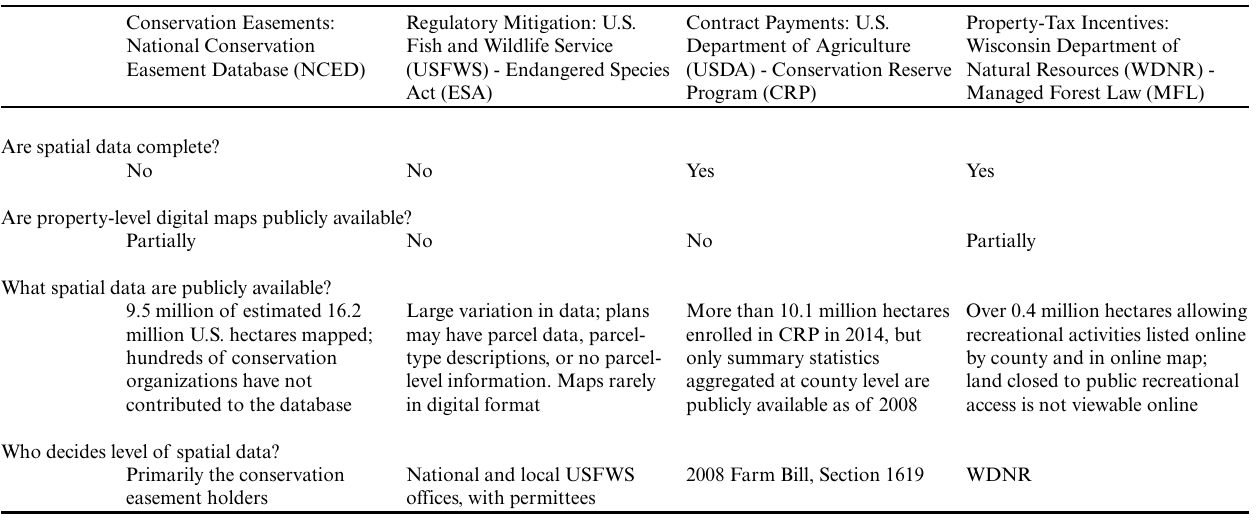
Table 2 . Public access to spatial data varied across four private-land conservation